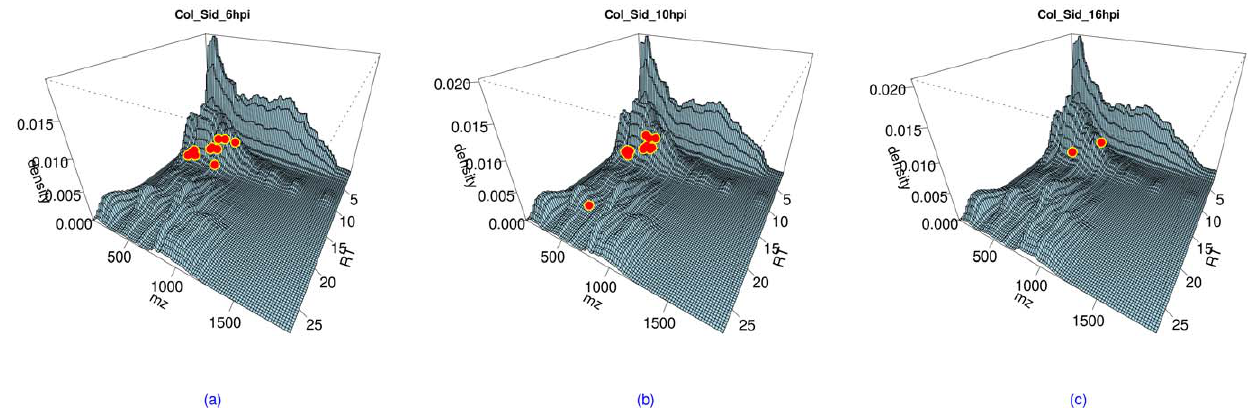
Figure 5. The location of significantly differential metabolites in R-M density surface. The significantly differential metabolites were shown using dots on the surfaces. (a) - left: for significantly differential metabolites between Col-0 and sid2 at 6 hpi. (b) - middle: for significantly differential metabolites between Col-0 and sid2 at 10 hpi. (c) - right: for significantly differential metabolites between Col-0 and sid2 at 16 hpi.